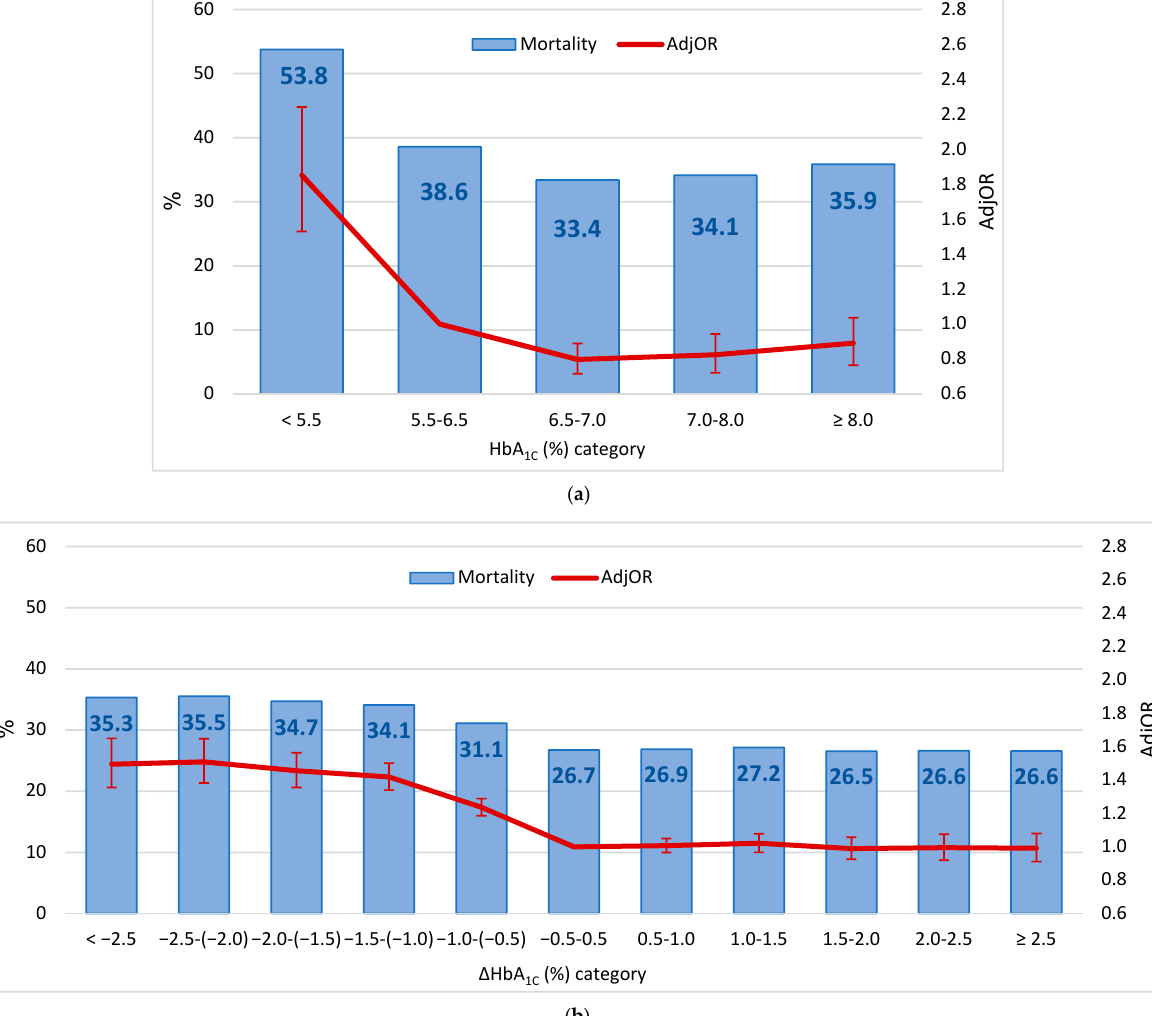
Figure 1. ( a ) The rates and the relative risks of mortality by HbA 1C (adjusted odds ratios and 95% CI) categories; ( b ) The rates and the relative risks of mortality (adjusted odds ratios and 95% confidence intervals) by HbA 1C categories. ( a , b ) are the results of separate models. Abbreviations: adjOR—adjusted odds ratio (adjusted for repeated measures), CI—confidence interval, HbA 1C —hemoglobin A1C, ∆ HbA 1C —the difference between two HbA 1C tests